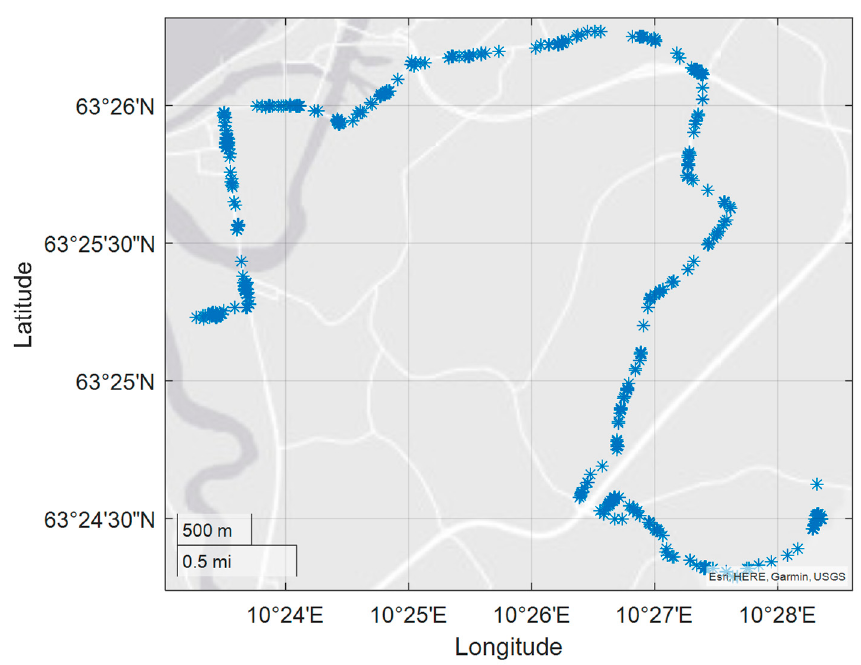
Figure A3. Route map of R55 for the demonstration.